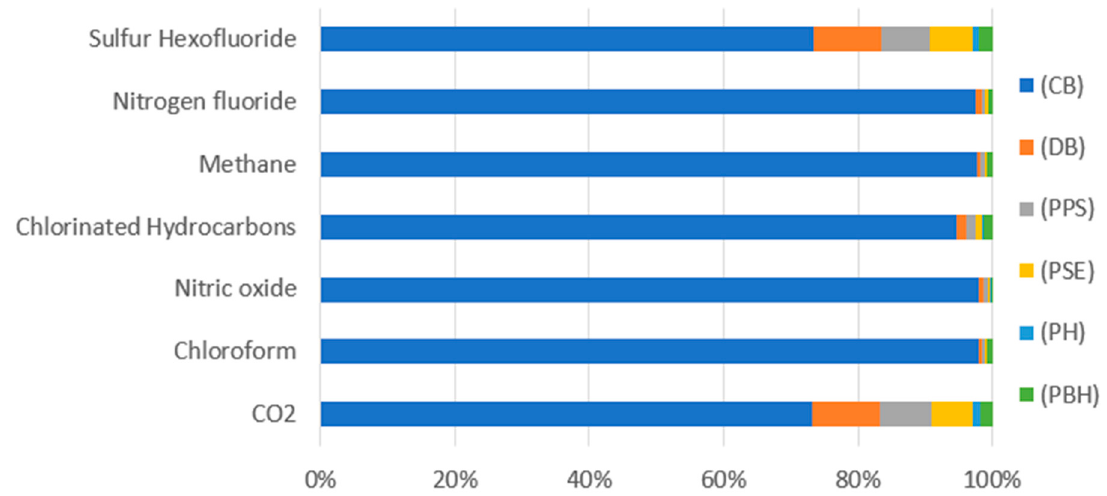
Figure 11. Results of environmental impact characterization for the category of global warming (species.yr).